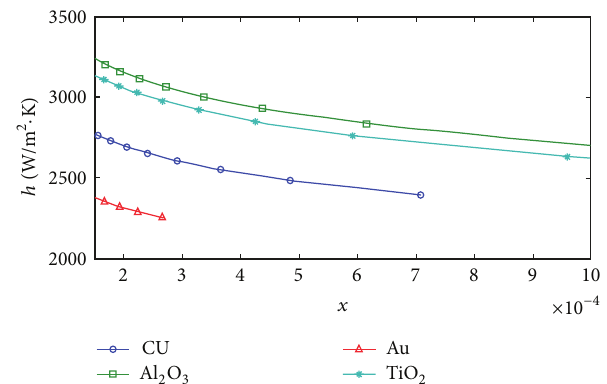
Figure 11: Variation of heat transfer coefficient against quality for all